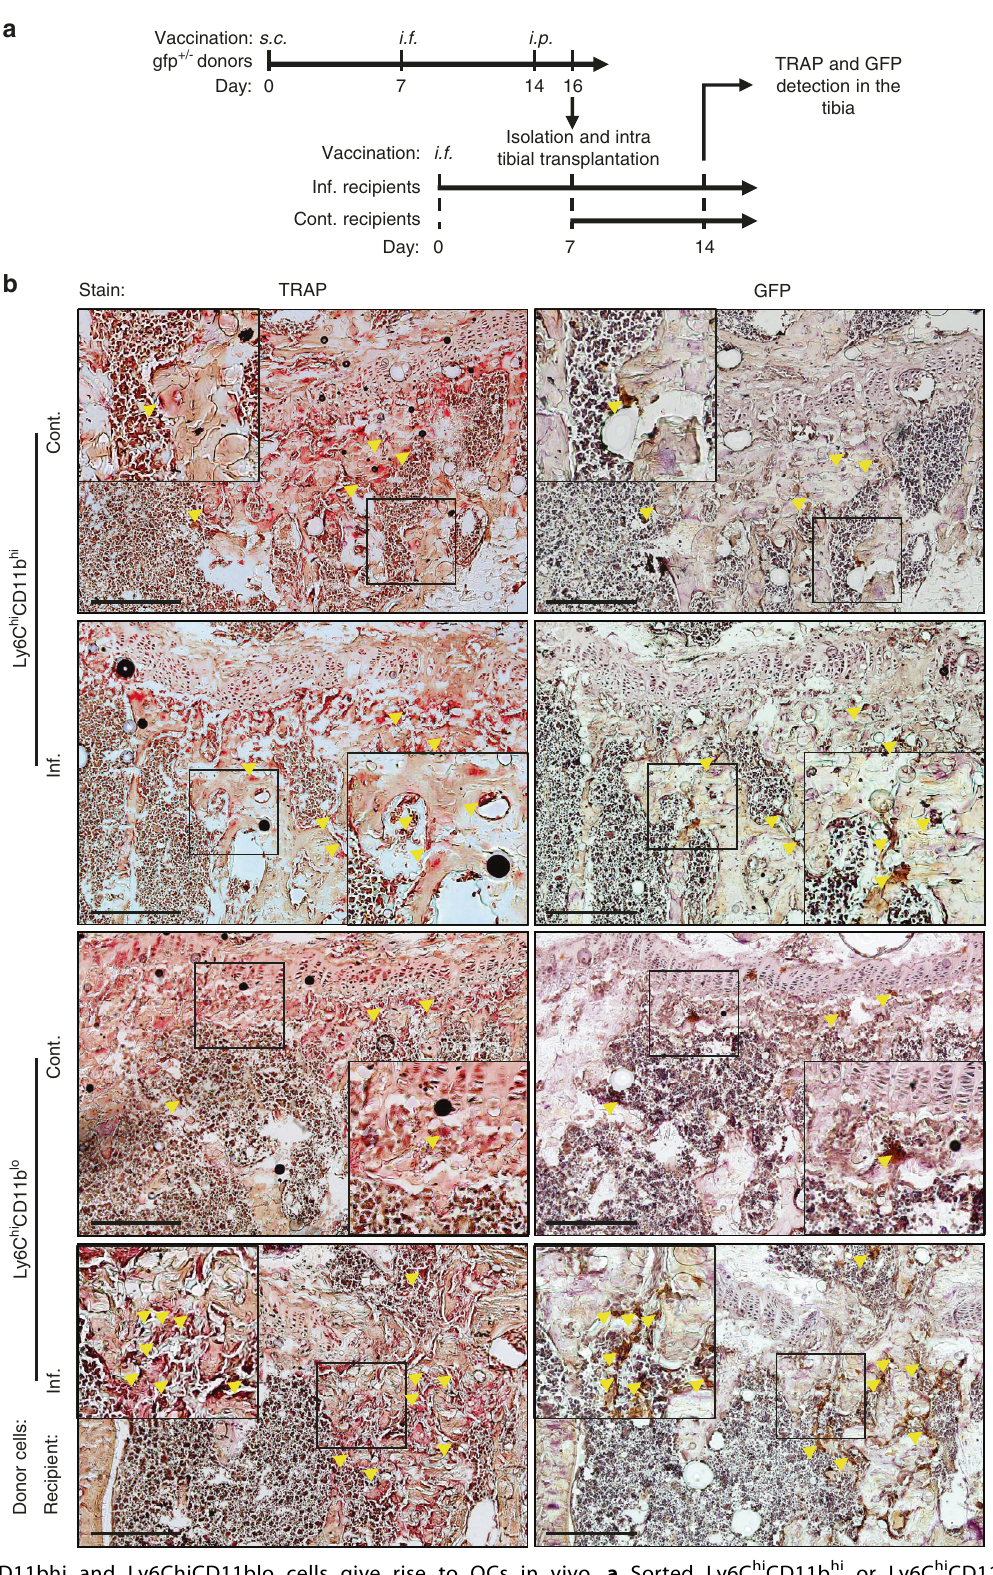
Fig. 3 Ly6ChiCD11bhi and Ly6ChiCD11blo cells give rise to OCs in vivo. a Sorted Ly6C hi CD11b hi or Ly6C hi CD11b lo cells (10 6 ) from the BM of in fl amed gfp donor mice were injected into the right tibia of inf. WT recipient mice 7 days after a single i.f . vaccination (left foot pad) or into that of sex/age-matched cont. mice. Recipient mice were sacri fi ced 7 days after transplantation. b TRAP staining (left panel) and GFP immunohistochemistry (right panel) of 7-µm consecutive sections from the right tibia of the recipient mice. Black frames are digitally enlarged, and locations positive for both TRAP and GFP are marked by yellow arrows. Scale bar, 400